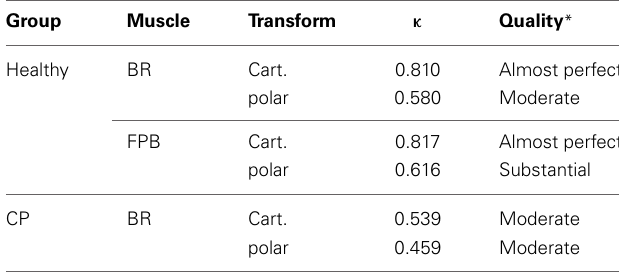
Table 4 | Inter-rater agreement across 4